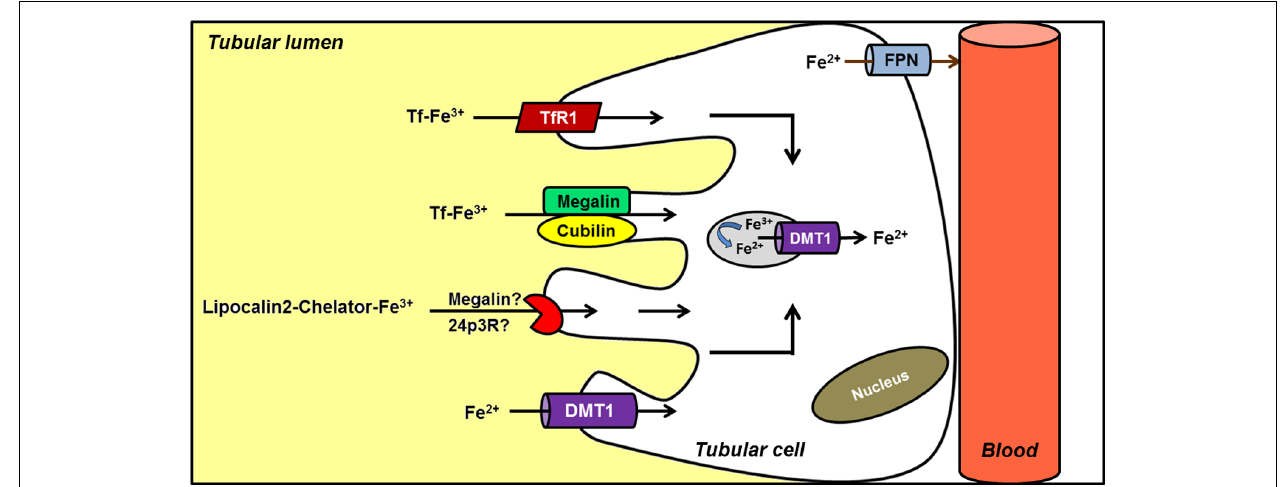
Although several features of the model are not completely known, it has been postulated that iron complexes could be endocytosed. Once in the endosome, iron would be reduced and released into the cytosol by endosomal DMT1. Finally, ferrous iron is exported by FPN located in the basolateral membrane; an apical distribution has been noted under conditions of renal failure.